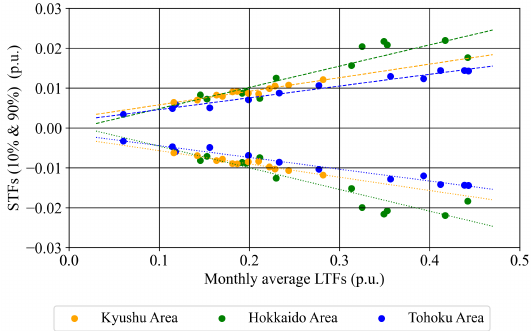
Figure 12. Scatter diagram of the 10th and 90th percentiles of short-term fluctuations in each month versus the monthly average long-term fluctuations in the three balancing areas in the 2012 fiscal year. The dashed lines indicate the least-squares approximations of these percentiles.